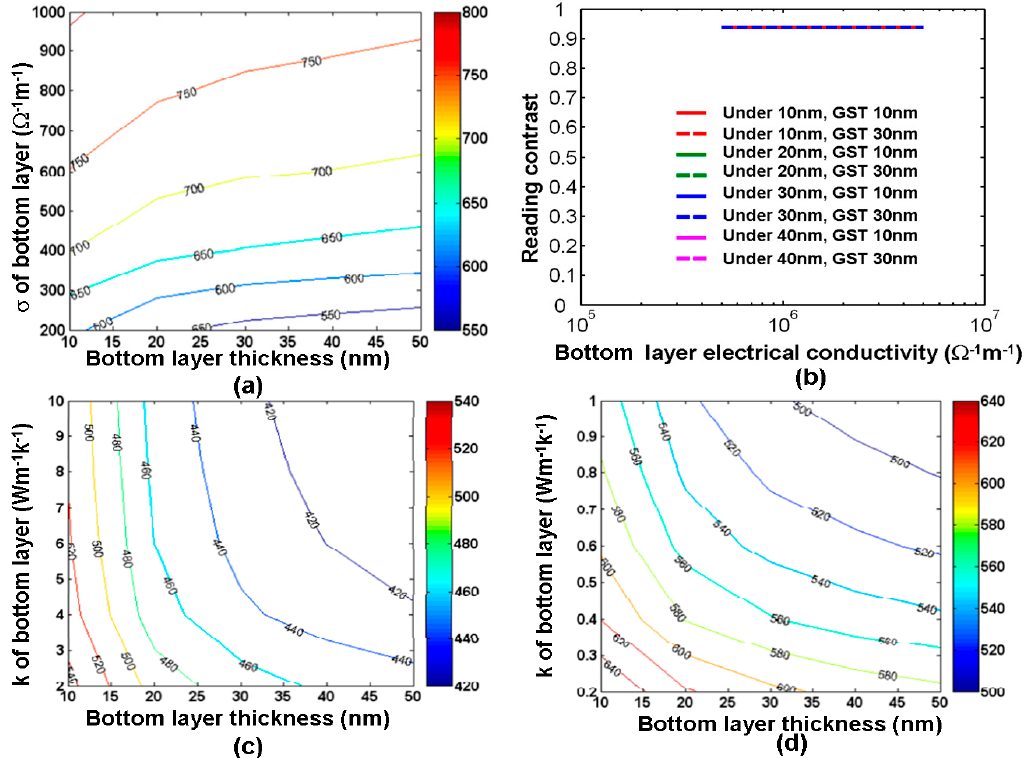
Figure 13. ( a ) maximum temperature ( ° C) inside the GST layer during crystallization as a function of the electrical conductivity and the thickness of the bottom layer by a 8 V pulse of 100 ns. ( b ) reading contrast as a function of the electrical conductivity and the thickness of the bottom layer for a single crystalline bit by a 1 V potential. ( c , d ) maximum temperature inside the GST layer during crystallization as a function of the thermal conductivity and the thickness of the bottom layer by a 8 V pulse of 100 ns. σ and k represent the electrical and thermal conductivities of capping layer respectively. Reproduced with permission from [26]. Copyright Ingenta Connect, 2015; [38].